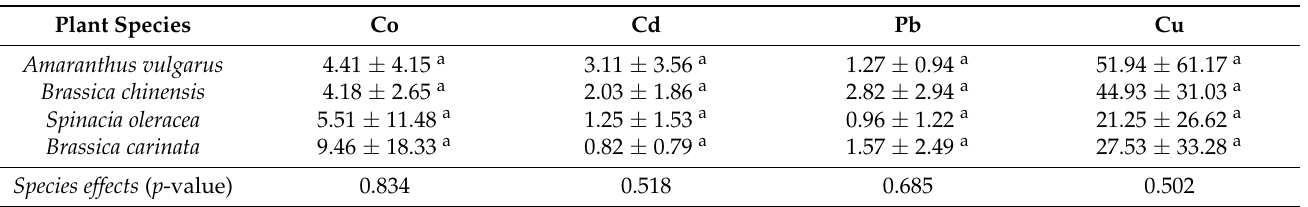
Figure 8. Spatial distribution of metals in the market garden soils according to their Soil pollution index. Table 5. Mean heavy metal concentrations (mg/kg) in 4 crops sold in the 33 selected markets of Lubumbashi (AFNOR U4441